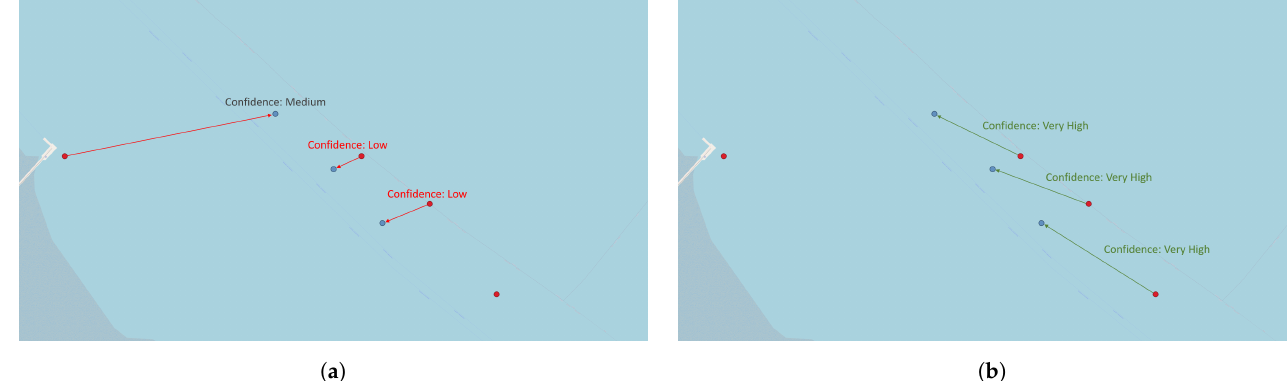
Figure 20. Rank-ordered assignment algorithm correctly updated from ( a ) rank 1 to ( b ) rank 3 AIS-SAR assignments (AIS data points shown in red and SAR ship detections shown in